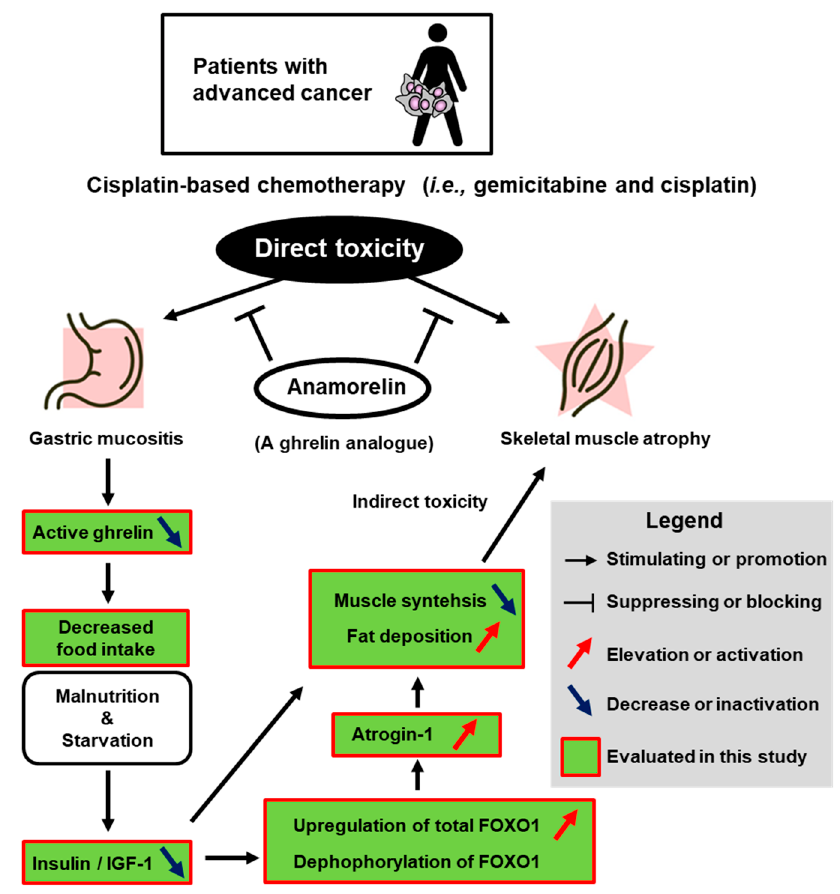
Figure 5. Schema summary of chemotherapy-induced adverse events and the potential of anamorelin intervention. IGF-1—insulin-like growth factor; FOXO1—forkhead box protein O-1 . intervention. IGF-1—insulin-like growth factor; FOXO1—forkhead box protein